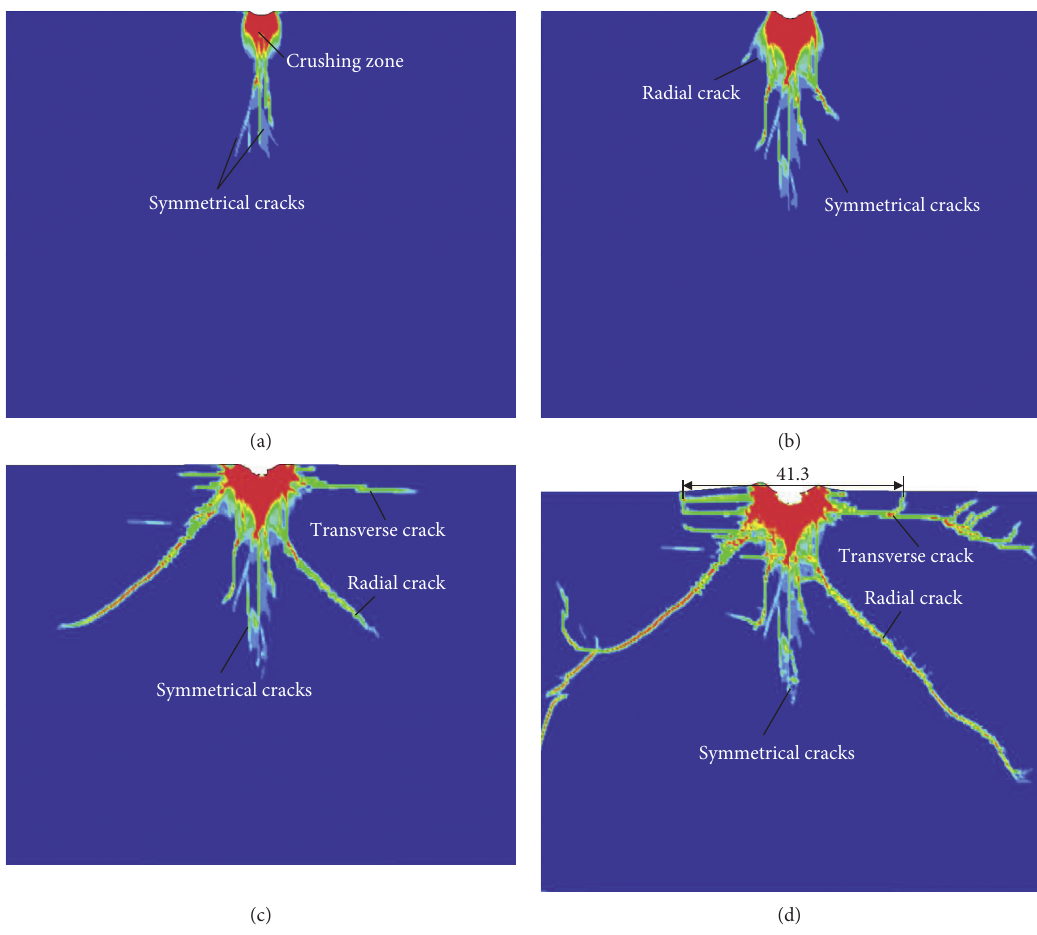
Figure 6: Rock breakage statuses at different times by the hemispherical indenter impact. (a) 0.35 μ s. (b) 0.73 μ s. (c) 1.9 μ s. (d) 3.8 μ